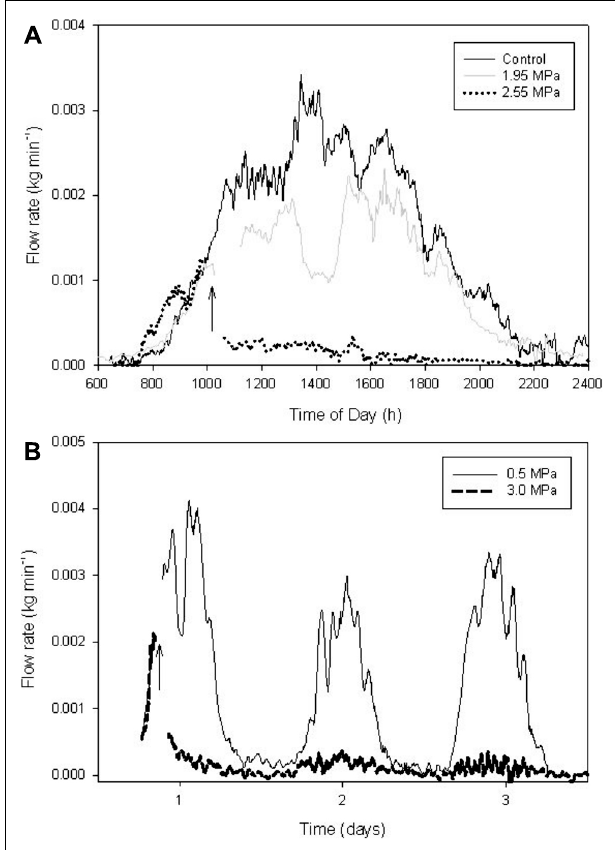
FIGURE 6 |Whole plant transpiration measurements made on potted plants of 3-year-old S. nigra trees collected using an analytical balance before and after air-pressurization treatments .The arrows indicate when pneumatic treatments were applied. (A) Shows three different plants pressurized with three different (cid:2) P pit air injection pressure treatments measured over a 24-h period. (B) Shows two plants subjected to (cid:2) P pit pressures of 0.5 and 3.0 MPa. Note that (cid:2) P pit pressures over 2.0 MPa resulted in reduced flow and non-recovery in S. nigra